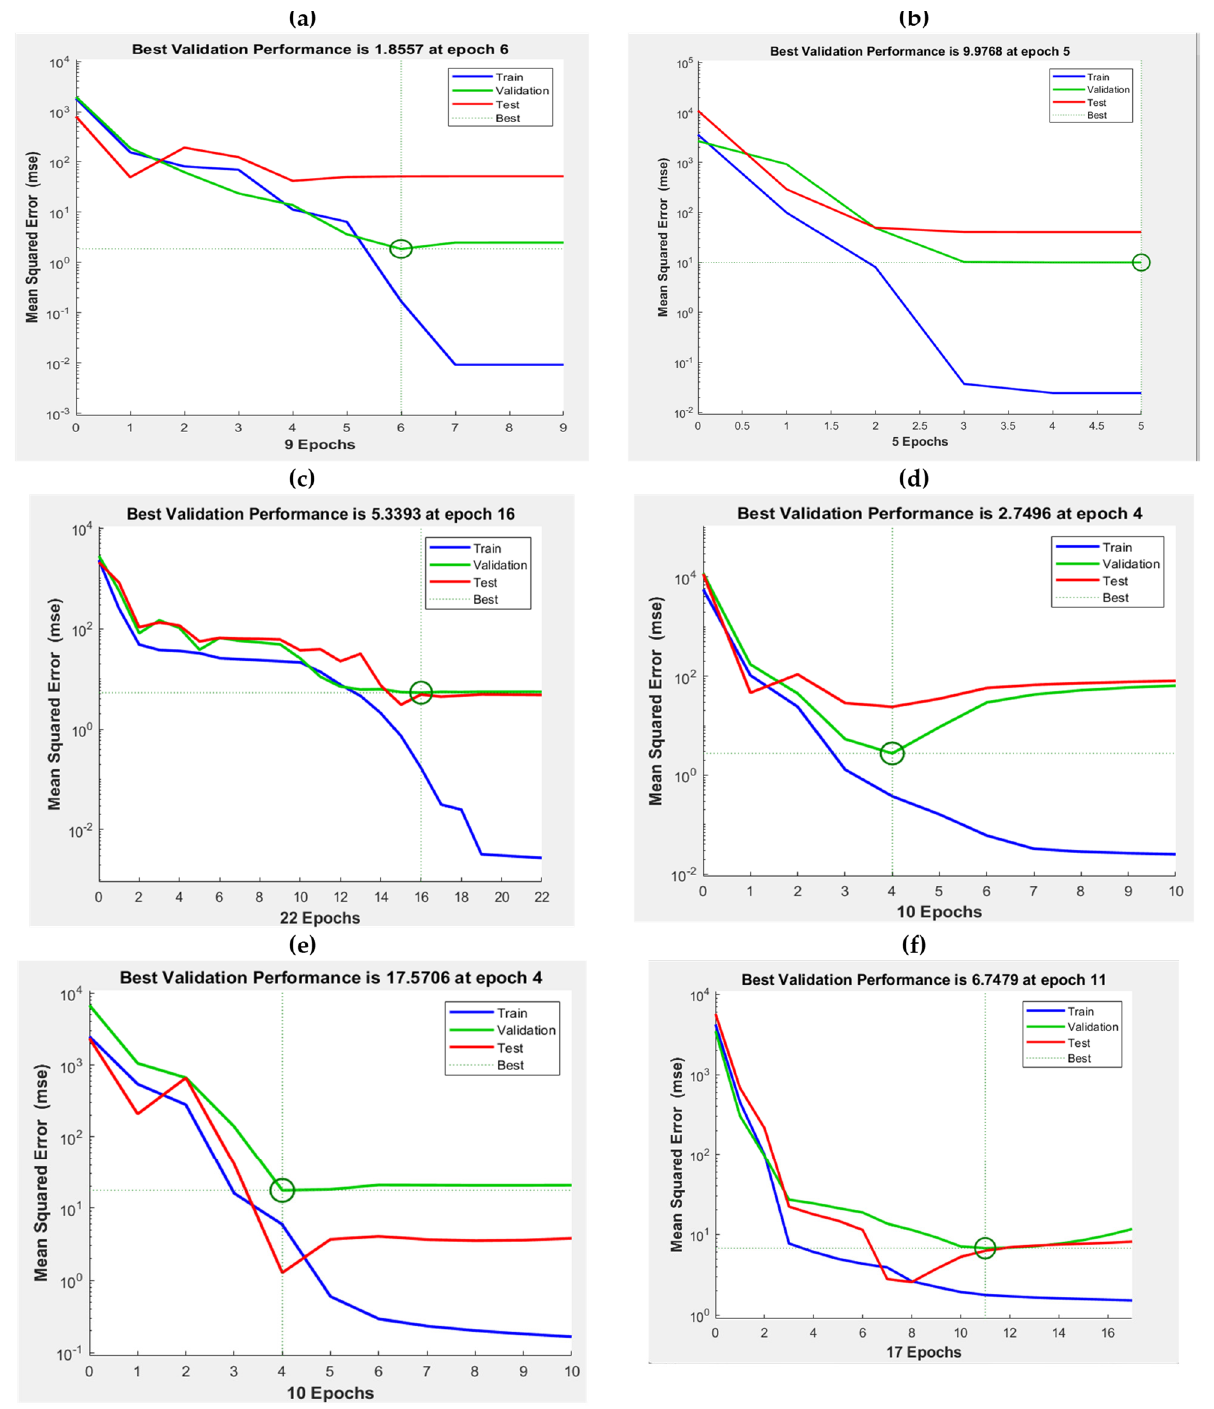
Figure 9. ANN-LMA model optimization strategy for FC-CCD ( a , b ); thermodynamics ( c , d ) and kinetics for Qe1 and Qe2 ( e , f ).